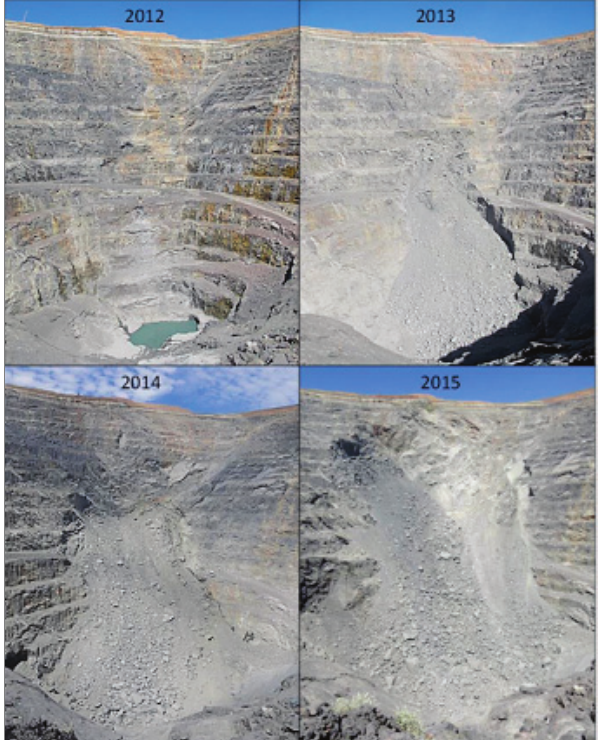
Fig. 6. Progression of caving-induced pit wall failure (Campbell et al.